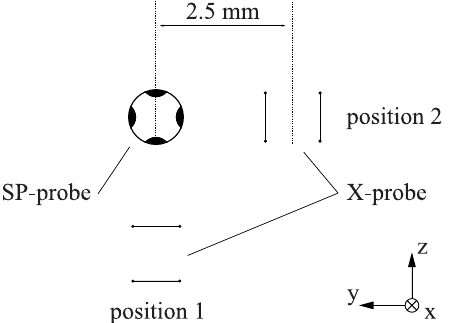
Fig. 2 Front view of the X- and SP-probes for the simultaneous measurement: position 1, for the measurement of u , v and p ; position 2, for the measurement of u , w and p